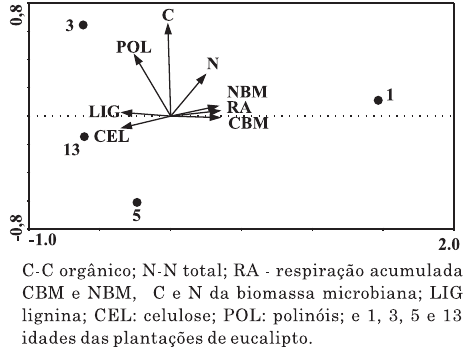
Figura 2. Diagrama de ordenação produzido pela análise de componentes principais dos atributos da